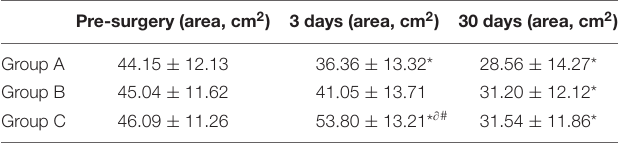
TABLE 5 | Numbness area in different voltages